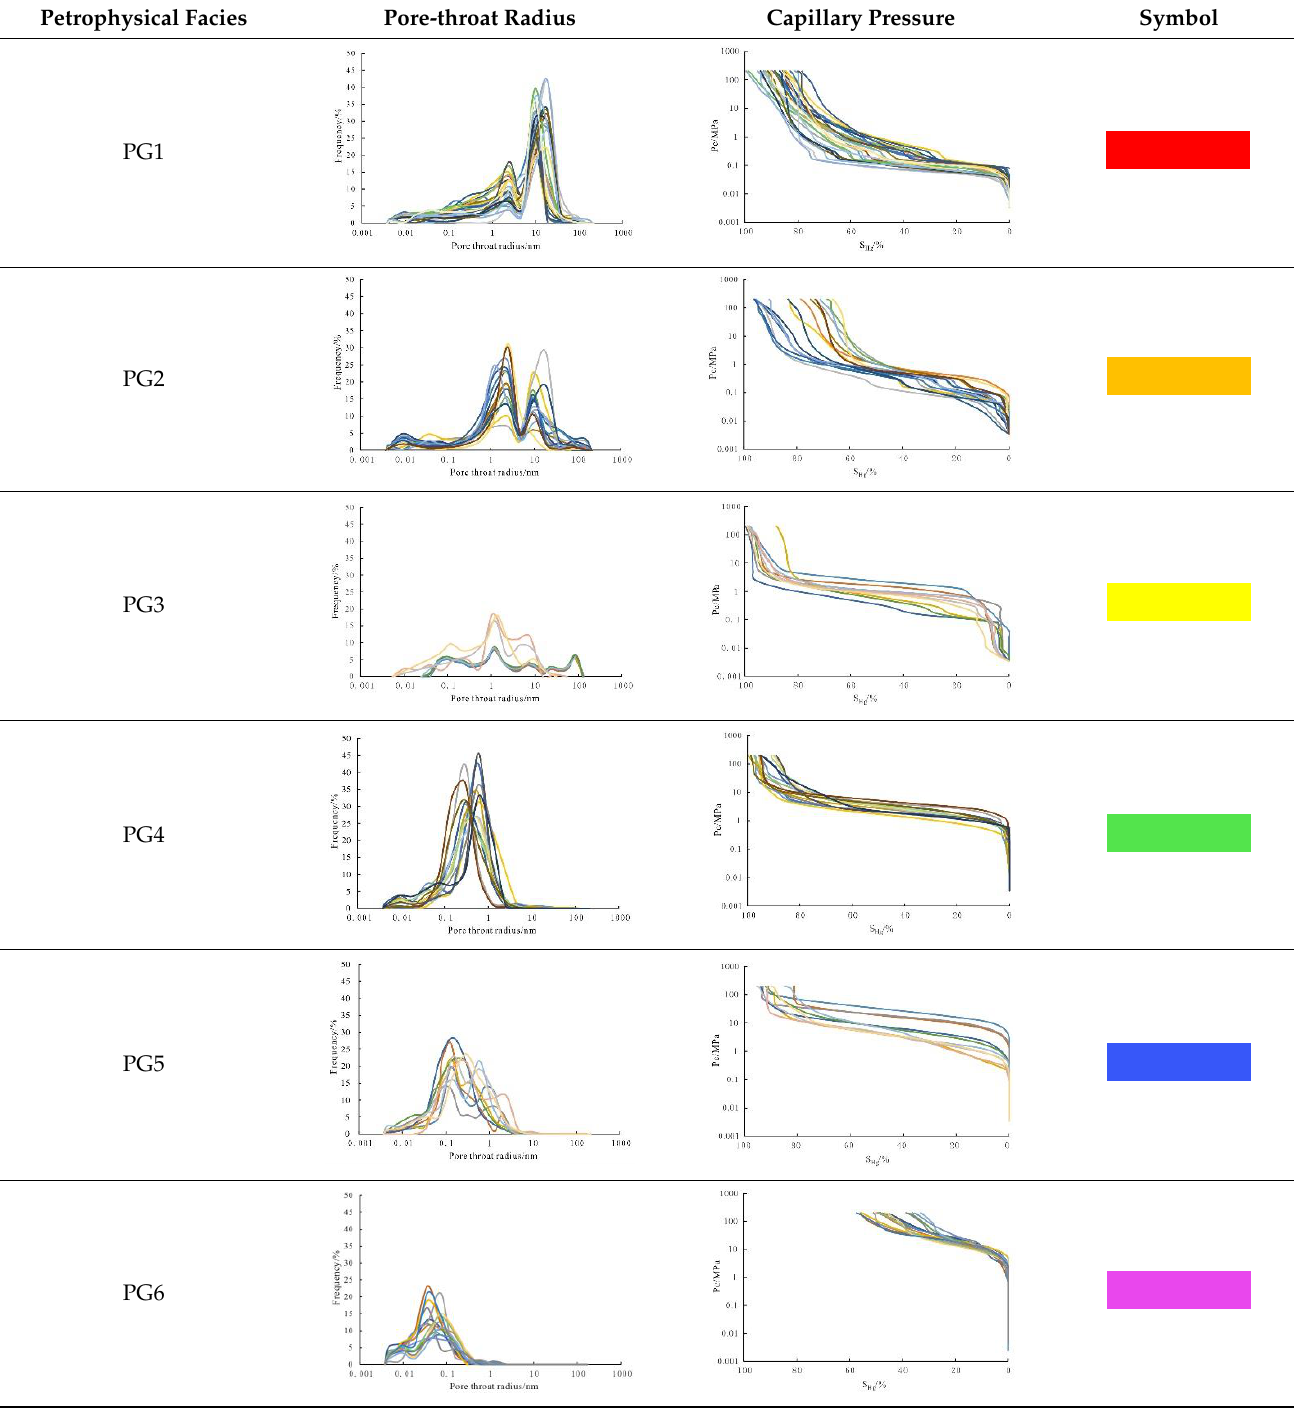
different rock samples of mercury injection, the pore-throat radius, and the capillary pres- sure curve of the same mercury intrusion rock sample are expressed in one color (Table 1). Table 1. Classification results of different petrophysical facies. The classification of petrophysical facies is based on the size of pore throat radius, namely pore size, which reflects the percolation ability of the reservoir. PG1 and PG6 represent the best and worst petrophysical facies, respectively.